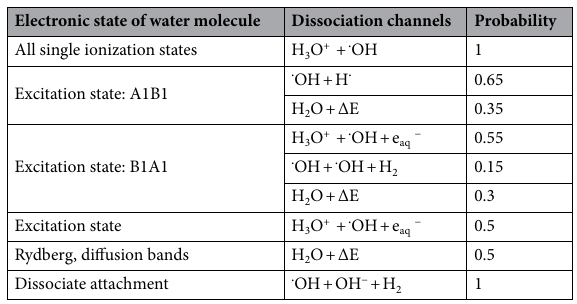
Table 2. Dissociation schemes and branching ratios. This table is recalled from Shin et al. 15